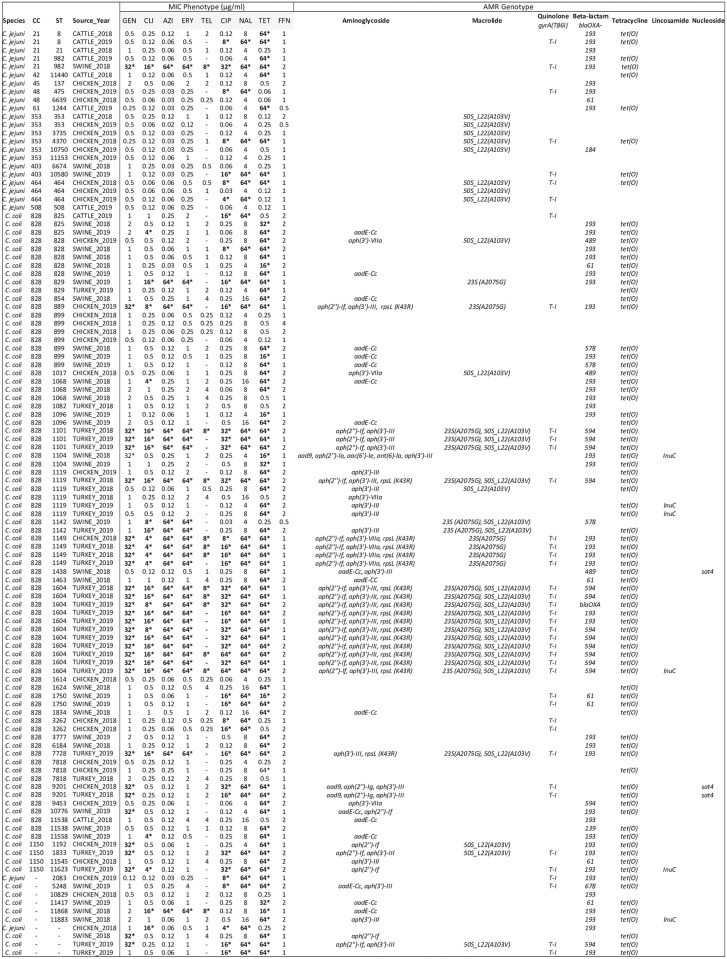
Campylobacter antibiotic susceptibility test results in live food animals aligned with AMR genotype, MLST, and source.Bold (*) = resistant. NARMS USDA-FSIS C. coli and C. jejuni minimum inhibitory concentration (MIC) results in μg/ml concentration for live food animals in North Carolina compared with MLST and AMR genotype. MIC was determined for the following antibiotics: Gentamicin (GEN), Clindamycin (CLI), Azithromycin (AZI), Erythromycin (ERY), Telithromycin (TEL), Ciprofloxacin (CIP), Nalidixic Acid (NAL), Tetracycline (TET), and Florfenicol (FFN).